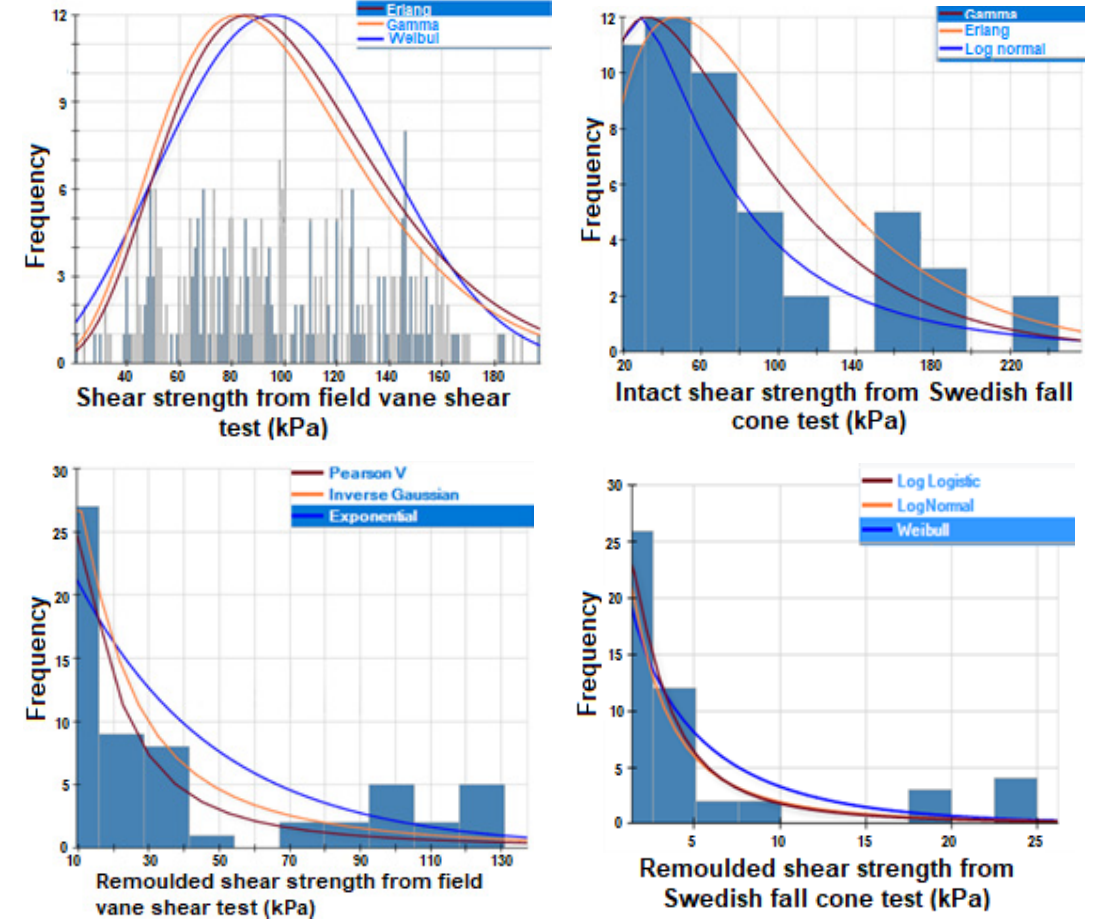
Figure 11. Adequate theoretical functions for the distribution of shear resistance and sensitivity